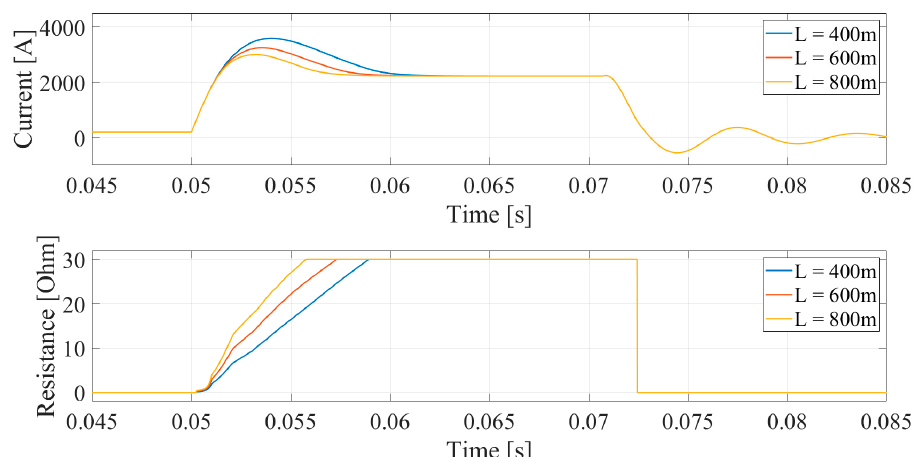
Figure 8. RQ model analysis for different tape length values.